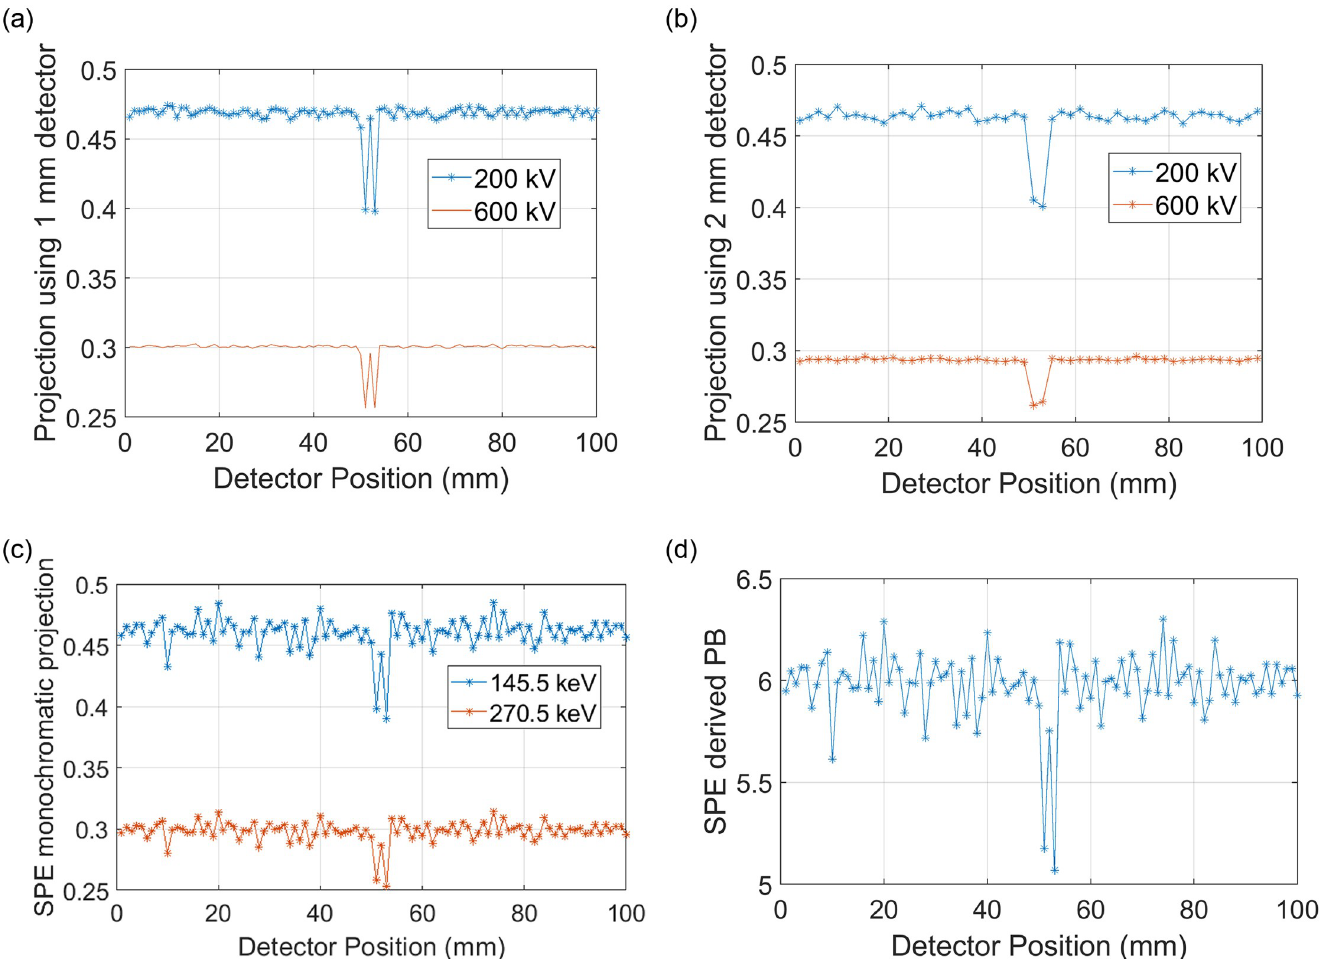
Fig 6. Line profiles for the 1 mm, 2 mm and 2 mm detector using SPE in (a), (b), and (c) respectively. (d) shows the PB line integral derived from the 2 mm detector element data using SPE.